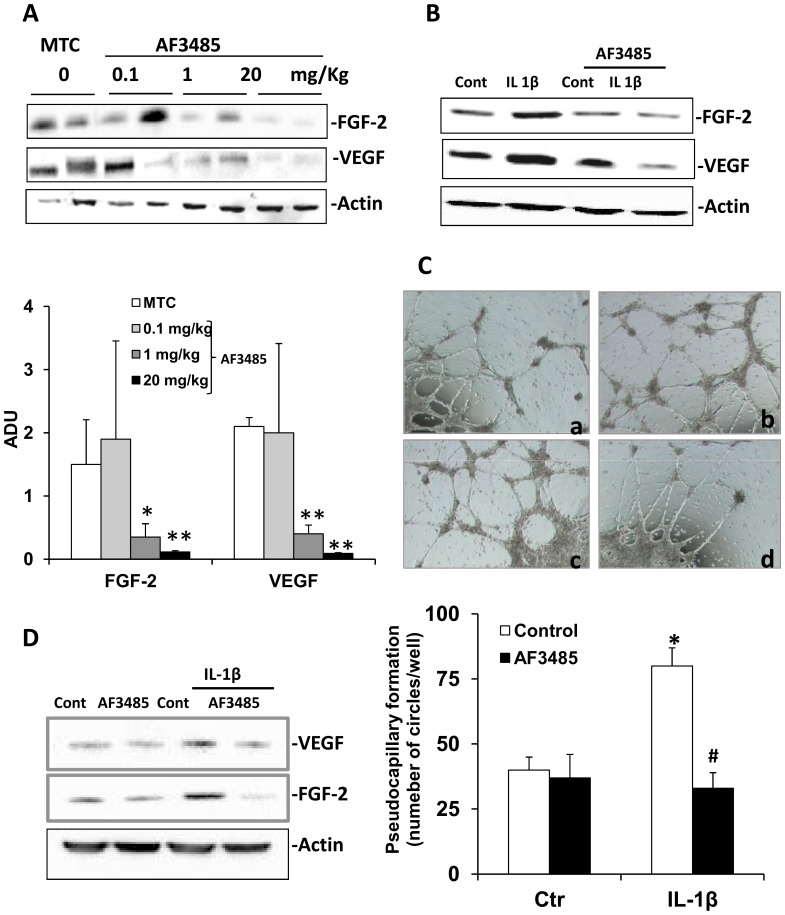
The mPGES-1 inhibitor AF3485 reduces VEGF and FGF-2 expression in tumors and in A431 cells.(A) VEGF and FGF-2 levels in tumors specimens and (B) in A431 cells treated with or without IL-1β (10 ng/ml, 18 h) in presence/absence of AF3485 (10 µM). *P<0.05, **P<0.01. ADU =  arbitrary density unit ± standard deviation. (C) Pseudocapillary formation of EC exposed for 16 h to conditioned media from A431 treated with 0.1% FBS (panel a: control), IL-1β (panel b: 10 ng/ml, 18 h), AF3485 (panel c: 10 µM, 24 h), IL-1β + AF3485 (panel d: 24 h) *P<0.01 vs. cont, #p<0.01 vs. IL-1β. (D) VEGF and FGF-2 expression in A431 cells co-cultured with NIH-3T3 for 24 h.